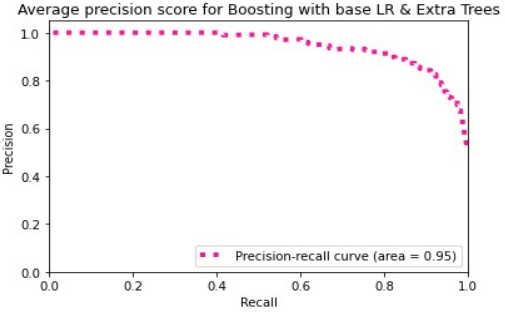
Figure 1. Precision-Recall Curve for all Classifiers.